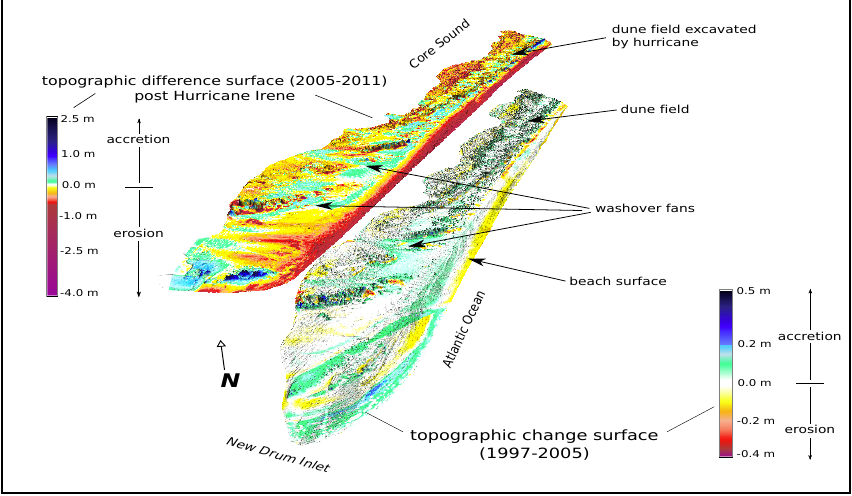
Figure 5. Core Banks site change surface (lower model) estimated using per-cell linear regression for the time period 1997–2005. DEMs for 1997, 2001 and 2005 were used to develop the model. The upper graphic (model) was developed using DEM differencing over the period 2005–2011, using the 2005 and 2011 DEMs, respectively. Both models show change in island topography (distribution and magnitudes of erosion and/or accretion, in meters) during the representative time